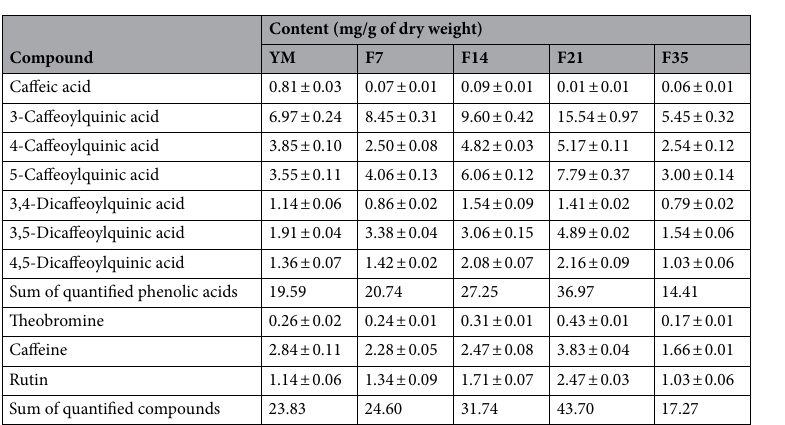
Table 2. Quantification results obtained for Yerba Mate extract end Kombucha ferments. Values are means ± standard deviation (SD) of triplicate.